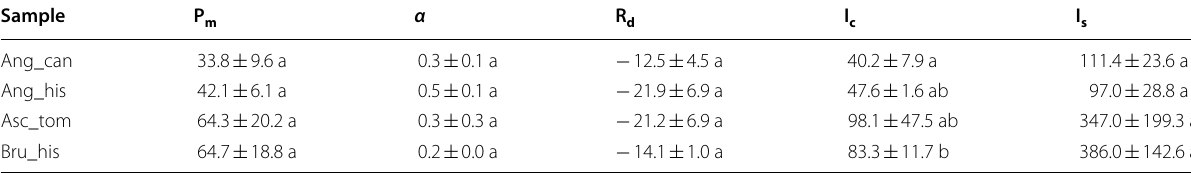
Maximum photosynthesis (P m ), dark respiration (R d ) in mmol O 2 h − 1 g chl a − 1 and light compensation point (I c ), light saturation irradiance (I s ) in µmol photons m − 2 s − 1 are presented. α in mmol O 2 h − 1 g chl a − 1 (µmol photons m − 2 s − 1 ) − 1 is the slope of the P/I curve at limiting irradiance. Sample size was n measurement of photosynthesis. Different letters indicate significant differences within photosynthetic parameters (Tukey HSD post hoc test, p < 0.05)